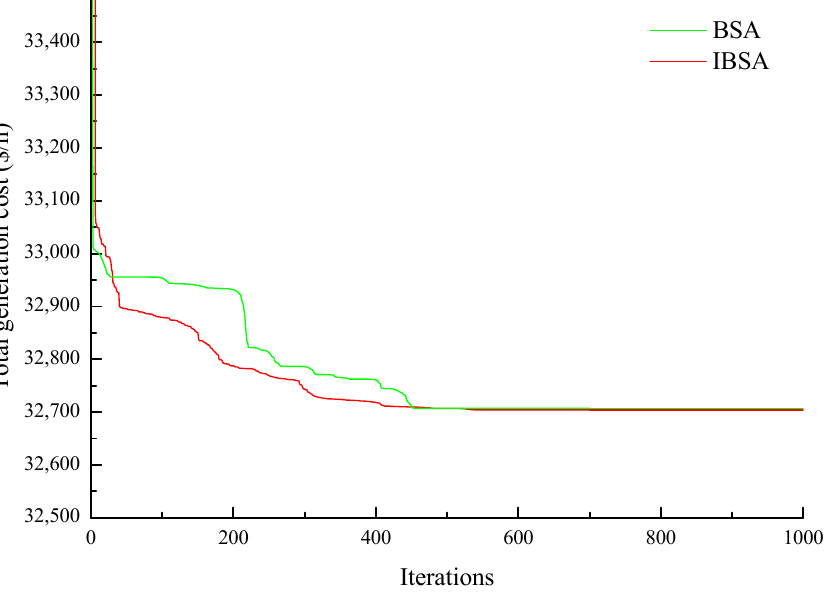
Figure 4. Distribution of results with BSA and IBSA in System 2.